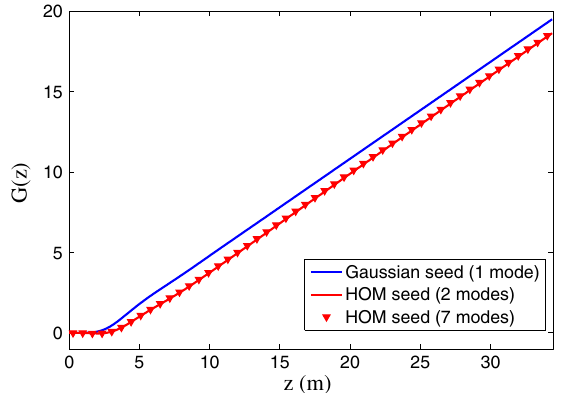
FIG. 7. Gain functions for an FEL driven by a matched beam (Set 2 parameters) and seeded with a Gaussian (blue solid line) mode (red solid line). Figures 8 and 9 also refer to and a GL 10 this configuration. These results have been obtained using the minimum number of expansion modes suitable for each case. Also included are 7-mode data for the HOM seed (red markers), which are in good agreement with the 2-mode